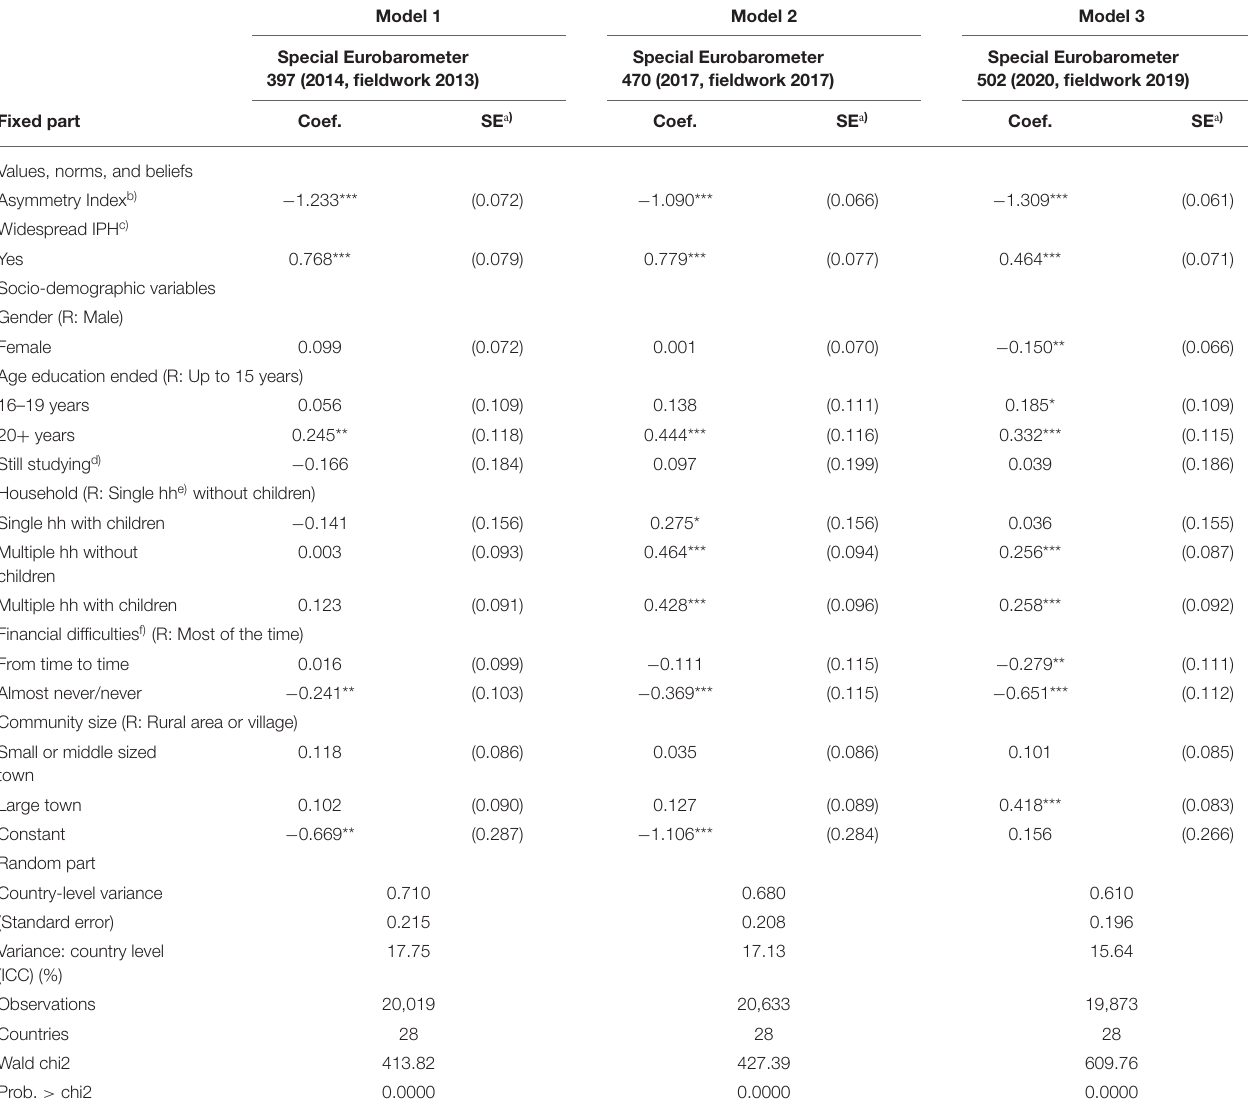
TABLE 2 | Multilevel logistic regression of the propensity to make informal payments for healthcare services in EU-27 and the UK—trends 2013, 2017,